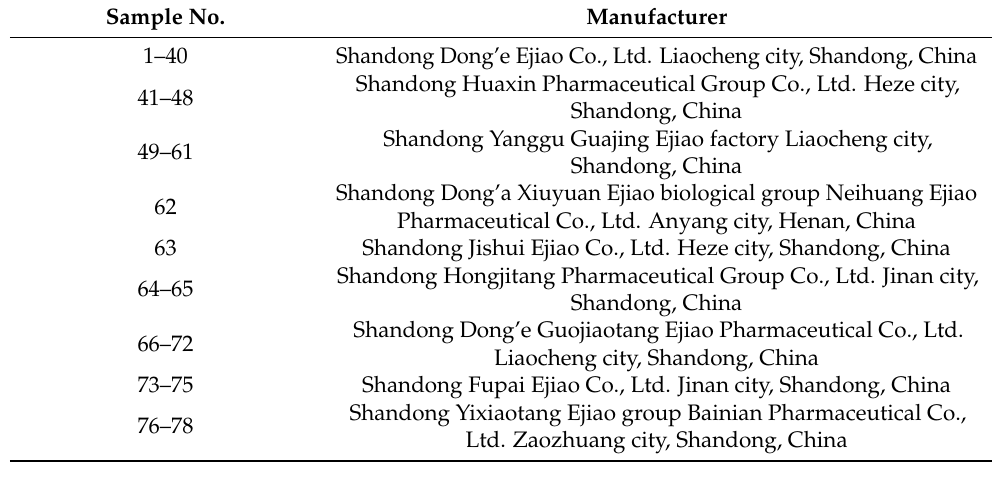
Table 2. Detailed information of all the CCA samples. Sample No.